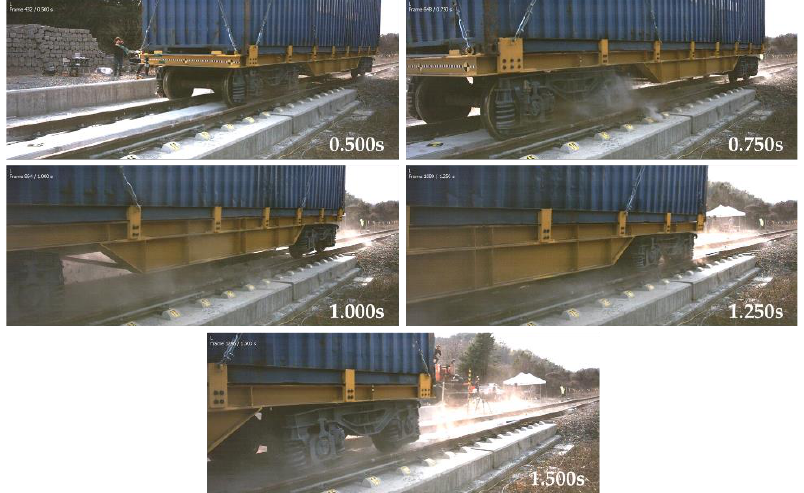
Figure 15. Post-derailment behavior of the container wagon (side view).